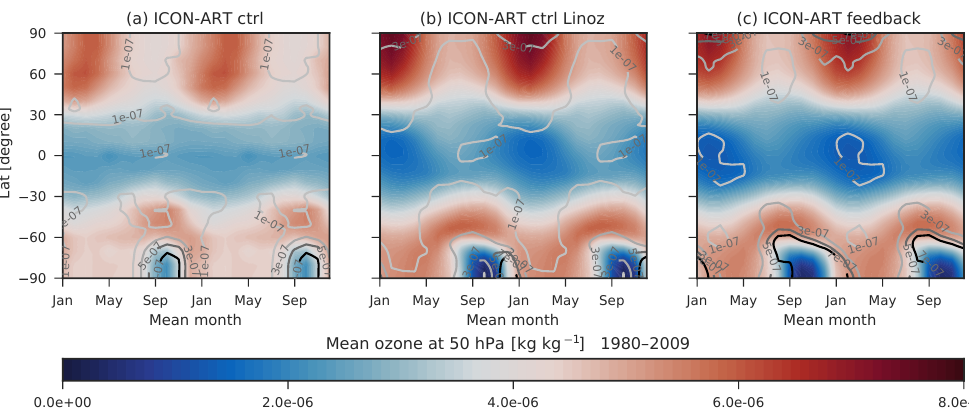
Figure B1. Monthly averaged zonal means of ozone (kgkg − 1 ) at 50hPa (shown twice) for the period from 1980 to 2009 (shaded). Contour lines represent the standard deviation of the monthly means. (a) Ozone climatology as used in the control simulation; (b) non-interactive Linoz ozone; (c) interactive Linoz ozone.